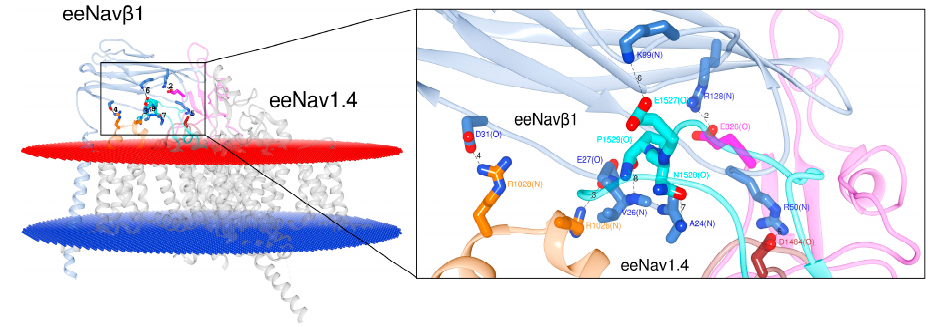
Figure 2. Display of the 3D model for S6 DIV in eeNa v 1.4 α / eeNa v β 1 [48]. The box displays details about the interacting residues at the interface. Labels 2 to 8: PPI identification numbers (PPI-Ids) of computed polar interactions (Table S1, Supplementary Materials); the amino acids are labeled by one-letter-codes with their primary sequence residue numbers and interacting atoms, e.g. A24(N). Colors: extracellular membrane boundaries (dark red); intracellular membrane boundaries (navy blue); transmembrane and intracellular protein regions of Na v α which do not participate in PPI (gray); Na v β 1 subunit (cornflower blue); S5 DI: magenta; S1-S2 DIII: orange; S5 DIV: brown; S6 DIV: cyan; computed polar interactions: black dotted lines. Visualization achieved by Chimera Alpha 1.14.